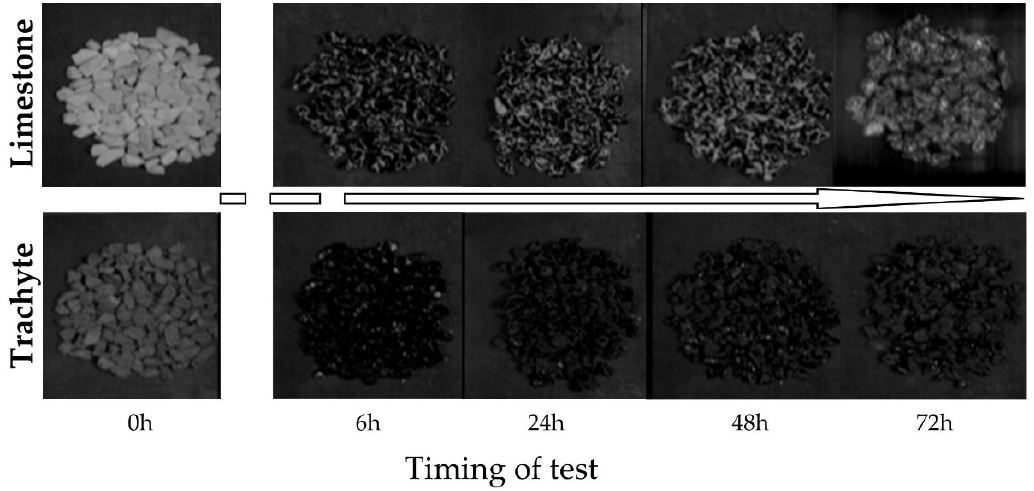
Figure 6. Limestone and trachytic samples acquired with the VIS spectrometer during the rolling-bottle test.